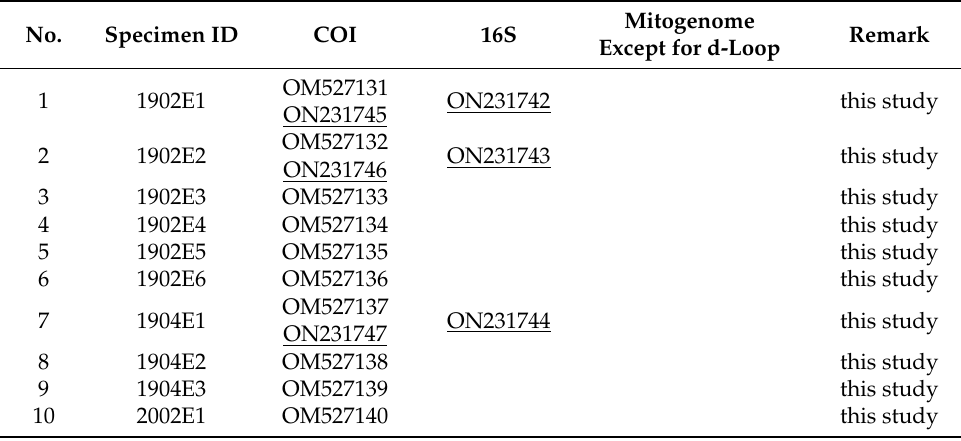
Table 1. GenBank accession numbers of eggs of this study and